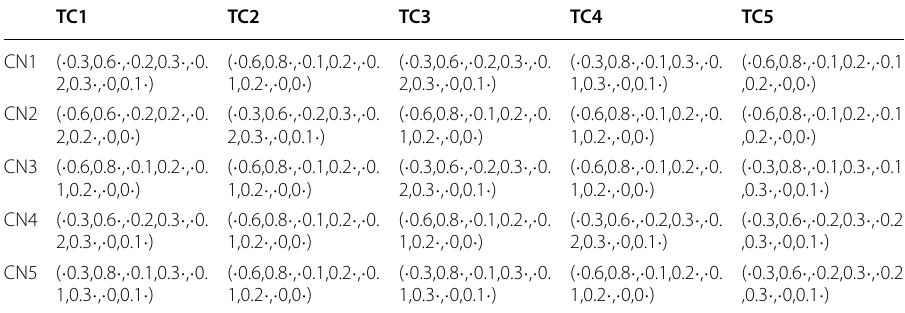
Table 25 Picture fuzzy rough sets for the phase 1 of